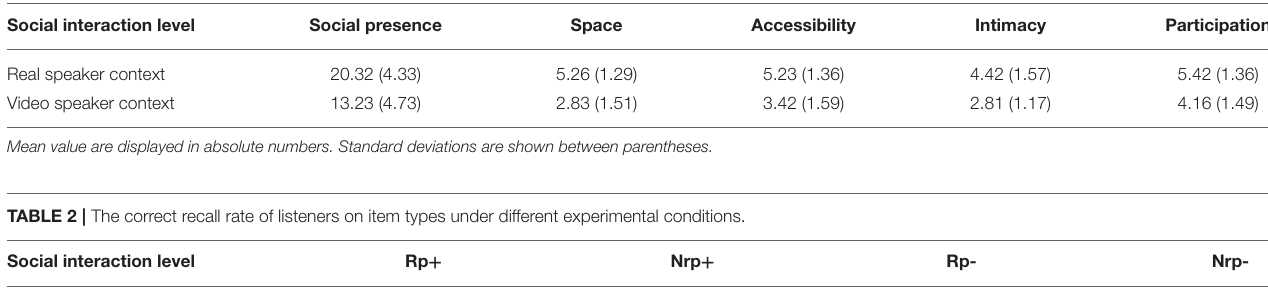
TABLE 1 | Descriptive statistics for factors influencing Listeners’ sense of social presence.